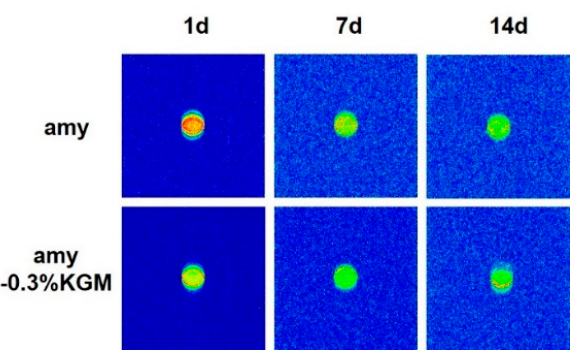
Figure 7. Water distribution of amylose–KGM mixtures at different storage times.